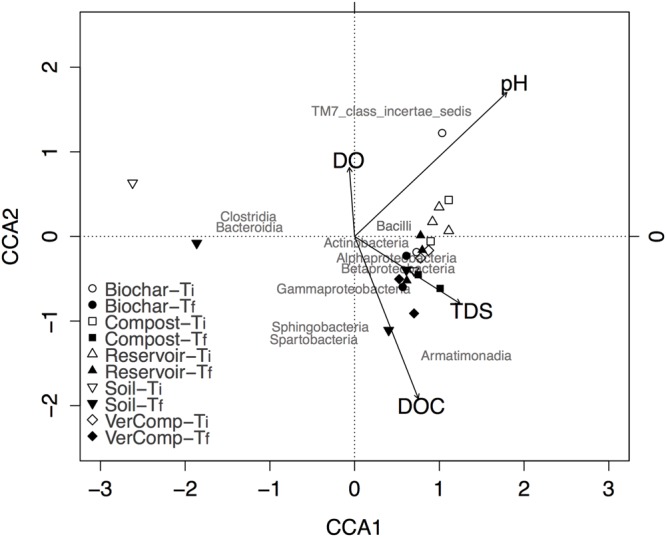
Biplot of canonical correspondence analysis of taxa abundance with environmental parameters in all samples at class level. Class of maximum abundance >1% at least in one sample was included in the analysis.